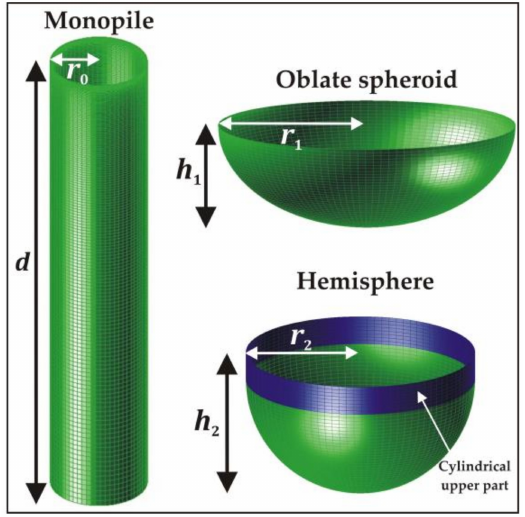
Figure 3. Submerged parts of all examined